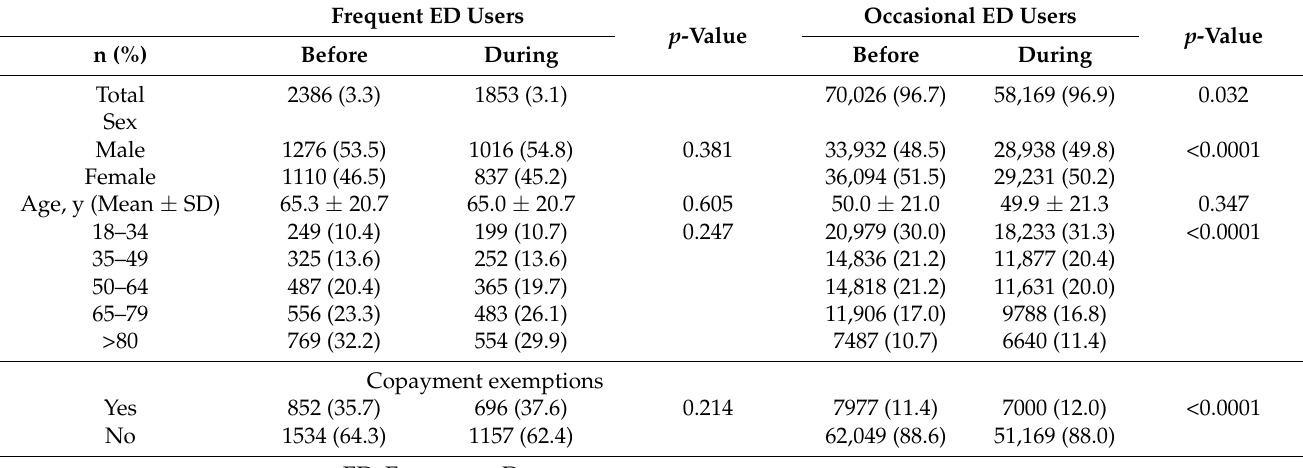
Table 1. Characteristics of ED patients before (February 2019–January 2020) and during COVID-19 pandemic (February 2020– January 2021) (n =